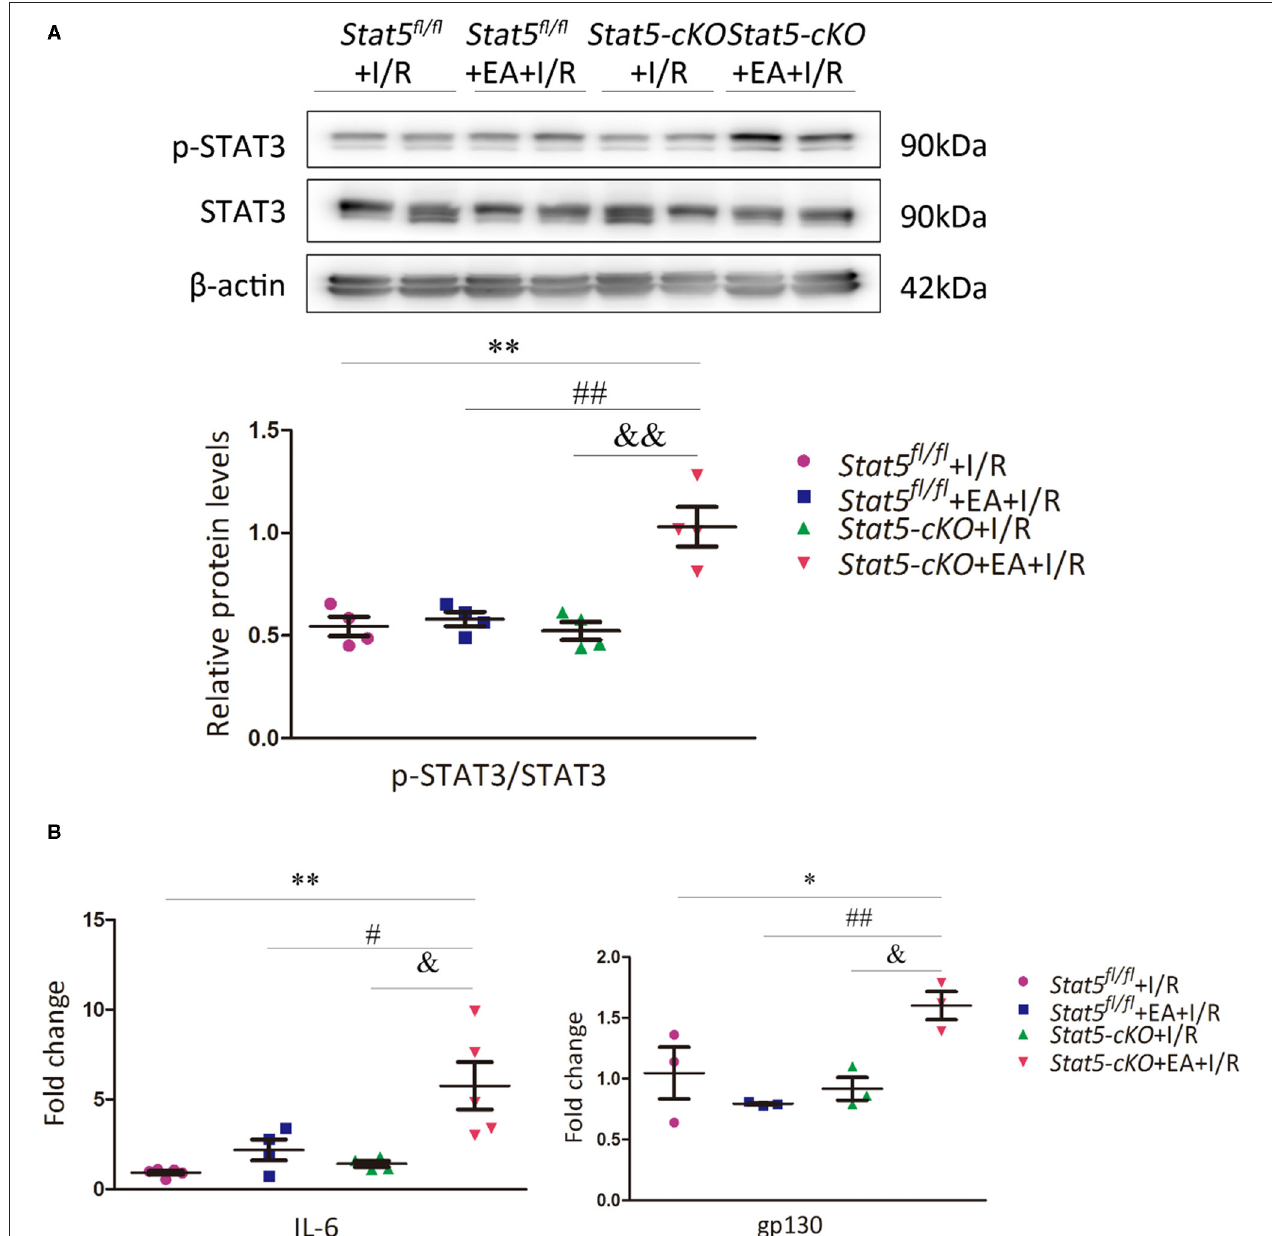
FIGURE 4 | The expression of IL-6/gp130/STAT3 axis-related molecules. (A) The protein expression of STAT3 and p-STAT3 was assessed by western blotting. ** P < 0.01 compared with the Stat5 fl / fl + I/R group; ## P < 0.01 compared with the Stat5 fl / fl + EA + I/R group; && P < 0.01 compared with the Stat5- cKO + I/R, n = 4. (B) The expression of Il6 and gp130 mRNA was measured by RT-qPCR. Data are presented as means ± SEM of at least three independent experiments. * P < 0.05, ** P < 0.01 compared with the Stat5 fl / fl + I/R group; # P < 0.05, ## P < 0.01 compared with the Stat5 fl / fl + EA + I/R group; & P < 0.05 compared with the Stat5- cKO + I/R group. Data were analyzed by two-way ANOVA with Bonferroni’s multiple comparison test, n = 3–5.